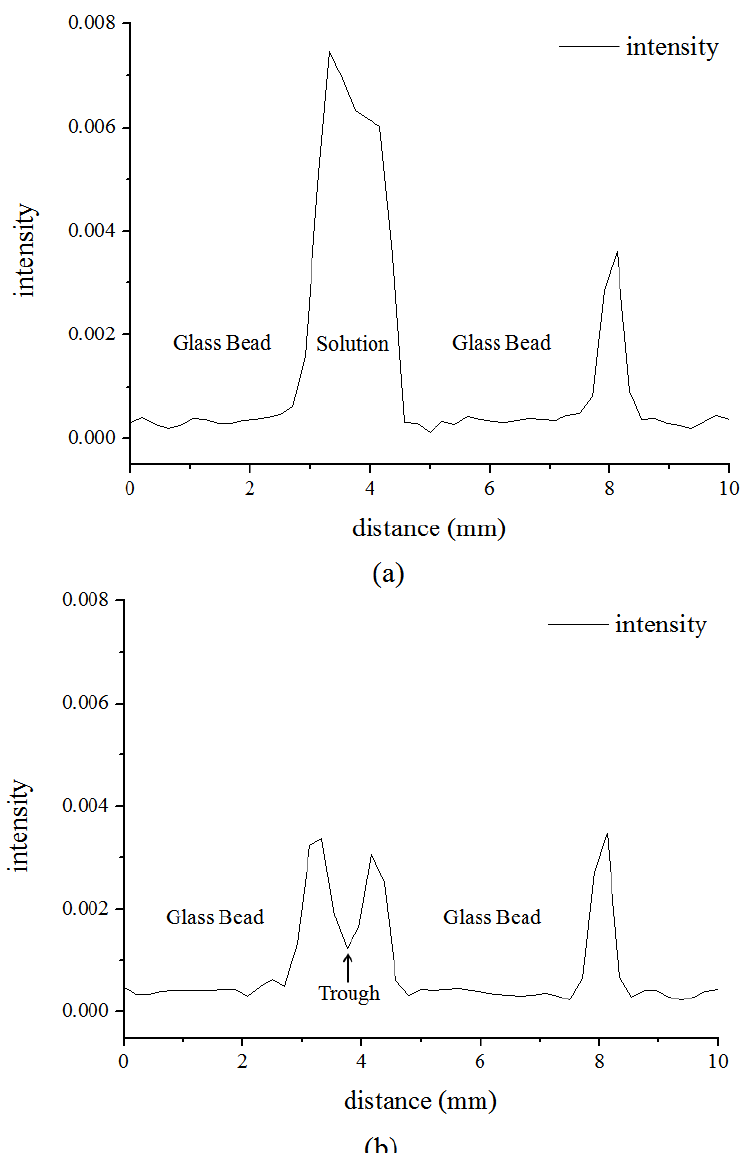
Figure 9. The images of the MRI signal intensity along the line in Figure 8. ( a ) At 305 min; ( b ) At 355